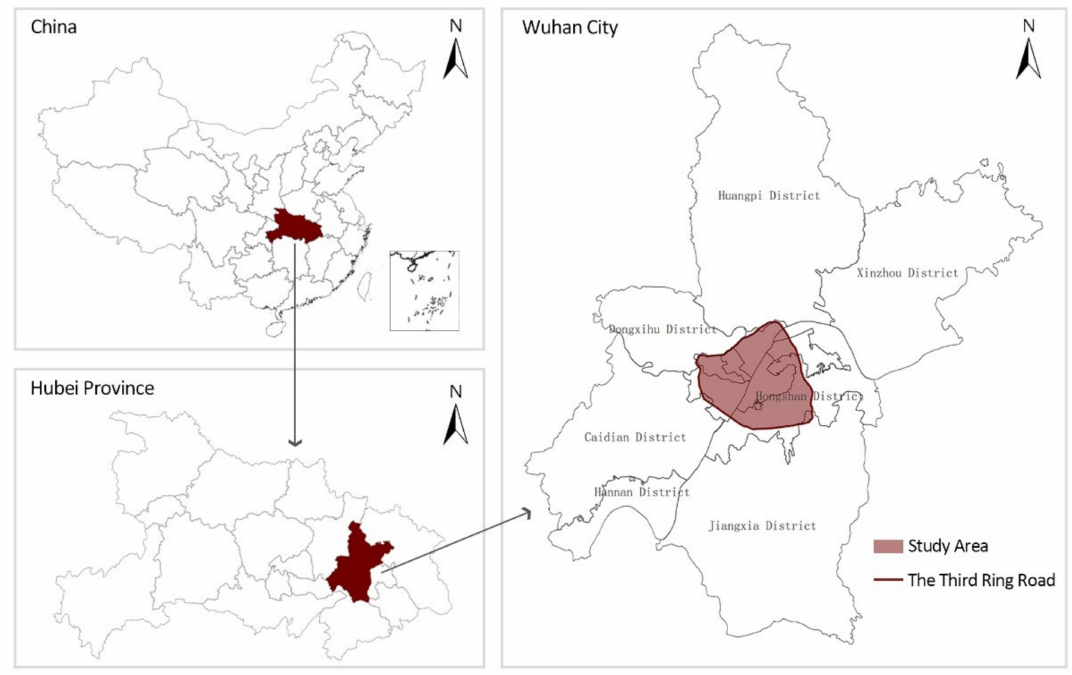
Figure 1. Map of the study area in